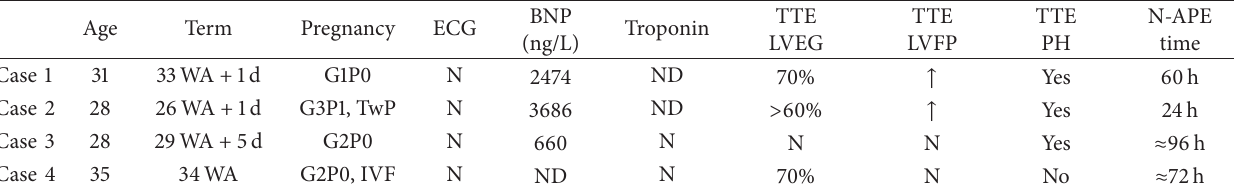
Table 1: Clinical and paraclinical characteristics in our series.